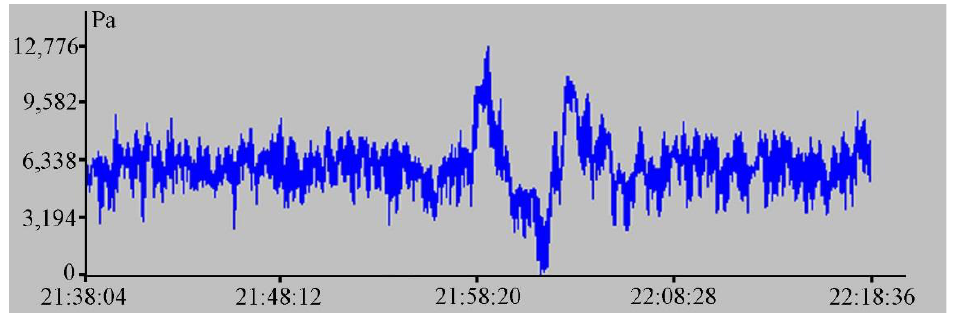
Figure 11. A recording section of the supersensitive detector of hydrosphere pressure variations for 8 June 2021 installed on the seabed at a depth of 27 m at Cape Shultz.